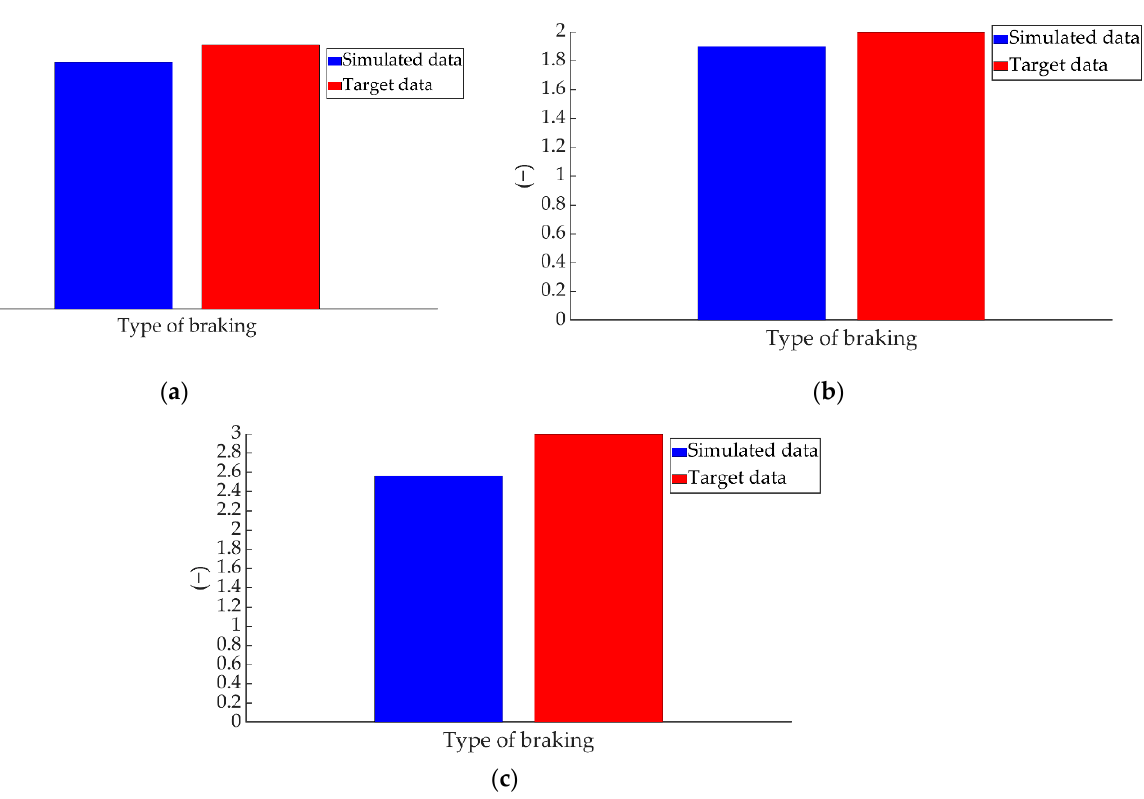
Figure 22. Comparison between ANN simulated data and vfill v target data for the left pressure sen- sor for braking at a speed of 70 km/h for the type: ( a ) maintained, ( b ) progressive and ( c ) emergency. Another of the simulated data refers to the type of braking performed. The compari- son between the simulated values and the target data of the braking type parameter for the three types of braking is shown in Figure 23.